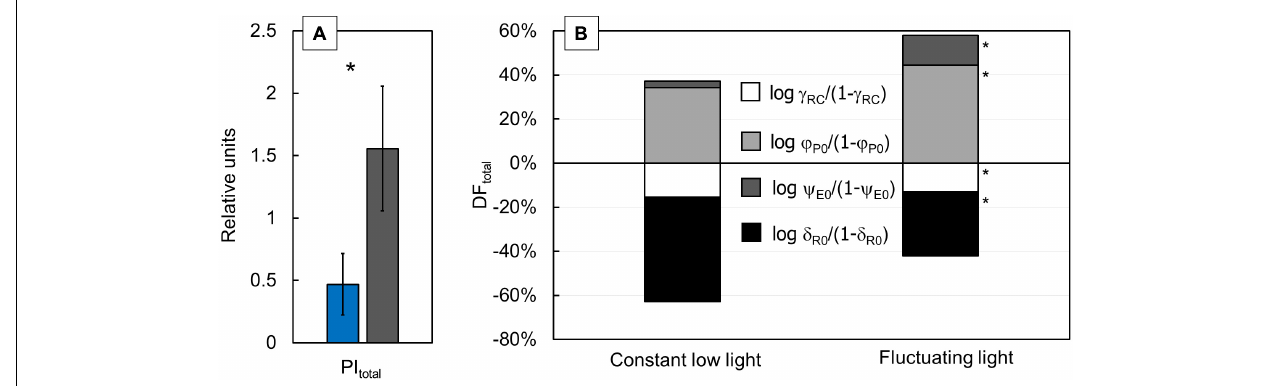
FIGURE 3 | Difference of the performance index for energy conservation from exciton to the reduction of the PSI end acceptors [PI total (A) ] was measured in the Japanese knotweed ( Reynoutria japonica Houtt.) leaves exposed to constant low light (blue bar) and fluctuating light (gray bar). Variation in the total driving forces [DF total (B) ] for each group of plants was calculated by summing up their partial driving forces: log γ RC /(1– γ RC ) (white), log ϕ P0 /(1– ϕ P0 ) (light gray), log ψ E0 /(1– ψ E0 ) (dark gray), and log δ R0 /(1- δ R0 ) (black). Represented values are the mean of 15 replicates per treatment. The asterisk (*) represents a significant difference at p ≤ 0.05 (using the Student’s t -test); error bars represent ± SD.